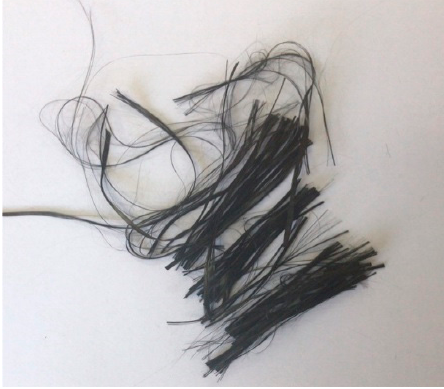
Figure 1. Carbon fibers. Table 1. Physical properties of carbon